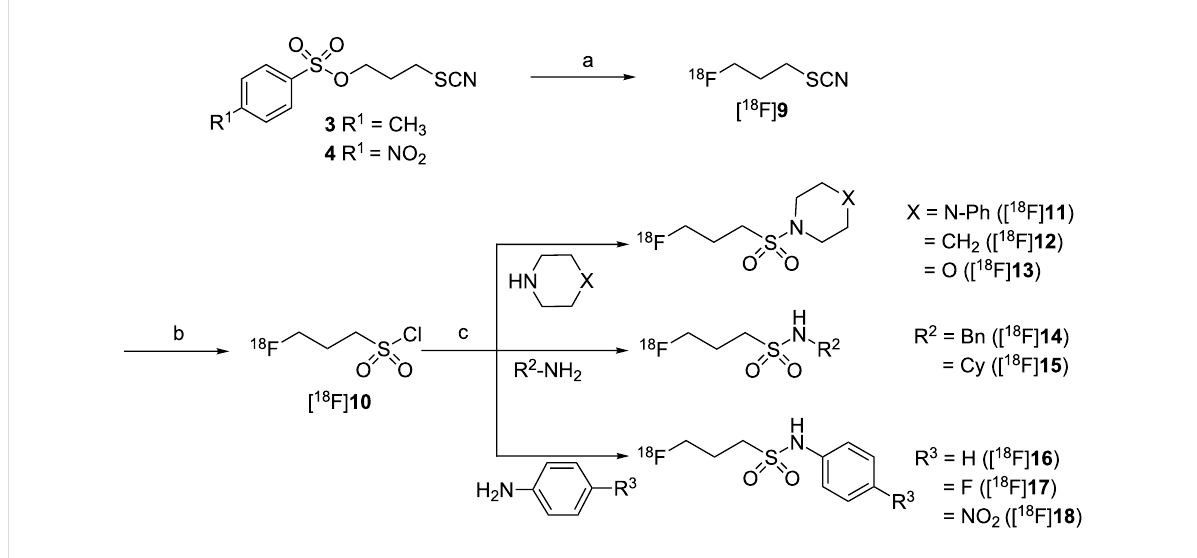
Table 2: Reaction of [ 18 F] 10 with various aliphatic and aromatic amines ( n ≥ 2). RCYs were determined by radio-TLC and refer to the fraction of the product related to the total 18 F-activity.